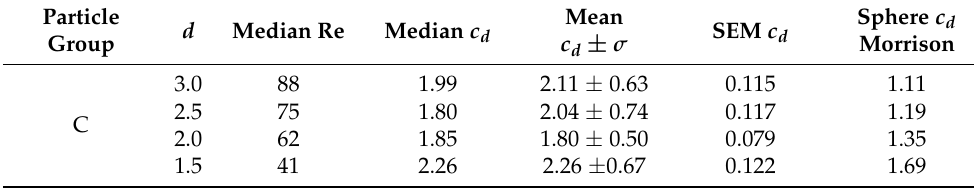
Table 4. Experimental data for particle group